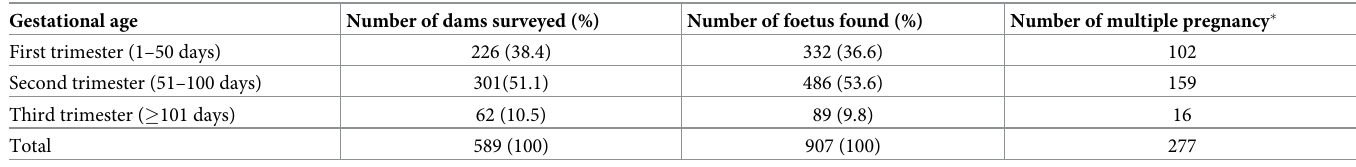
Table 3. Gestational age distributions of pregnant goats slaughtered and the corresponding number of foetuses recovered at Akwata and Artisan slaughterhouses in Enugu, Nigeria. Gestational age